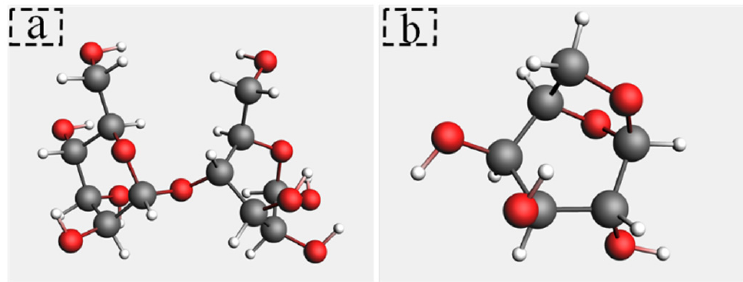
Figure 3. Molecular model. ( a ) is cellobiose; ( b ) is LGA.